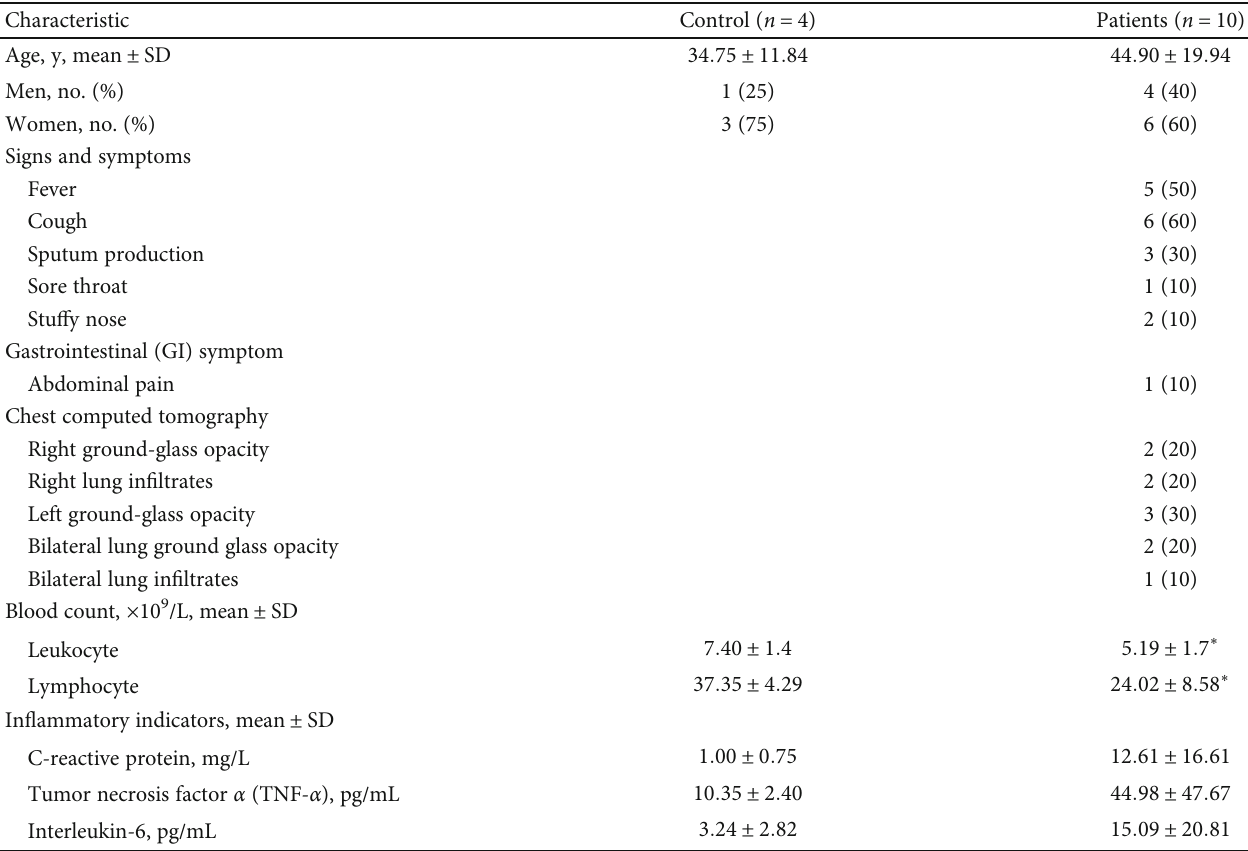
Table 1: Clinical characteristics of subjects with COVID-19 and health